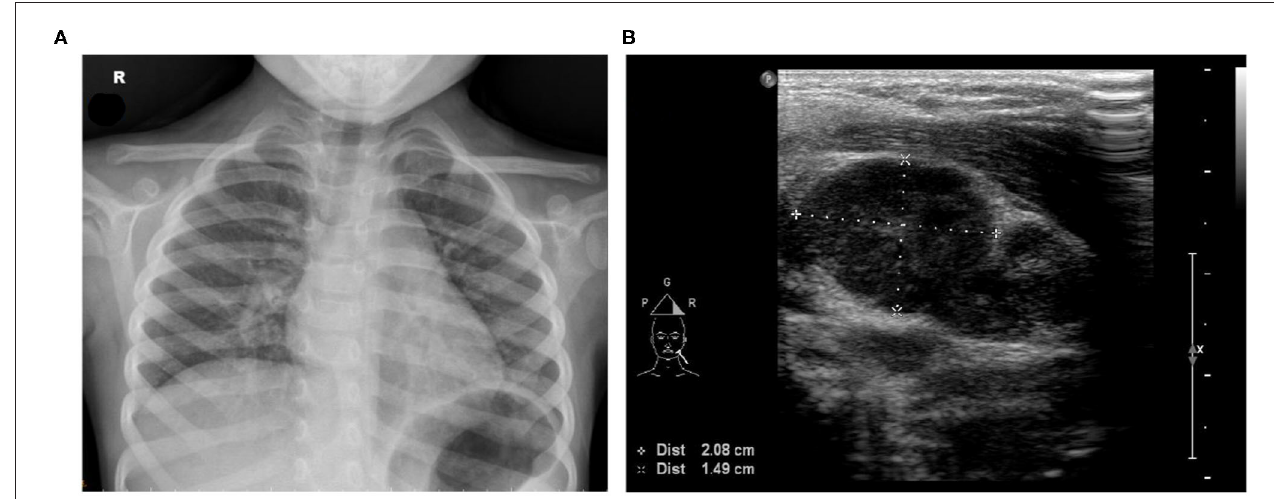
FIGURE 1 | (A) Chest X-ray image exhibiting increased bronchoalveolar infiltration over the right lung field. (B) Neck tissue echography revealing multiple lymphadenopathy on the left side of the neck (largest dimensions: 2.08 × 1.49